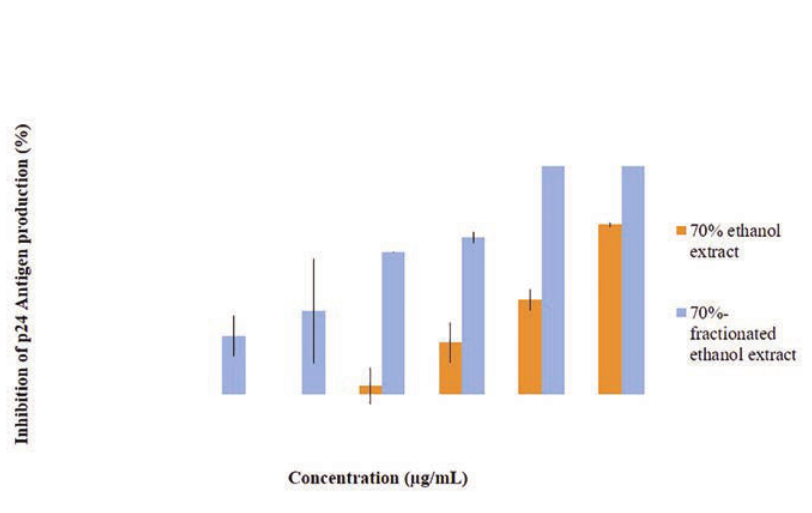
Figure 4. The percentage of p24 antigen expression inhibition on HIV-infected MOLT-4 cells of 70%-fractionated ethanol extract and 70% ethanol extract from J. gendarussa leaves with various concentrations. It was measured after 72 hr incubation under condi- tions. Error bars show the standard deviation from average of three